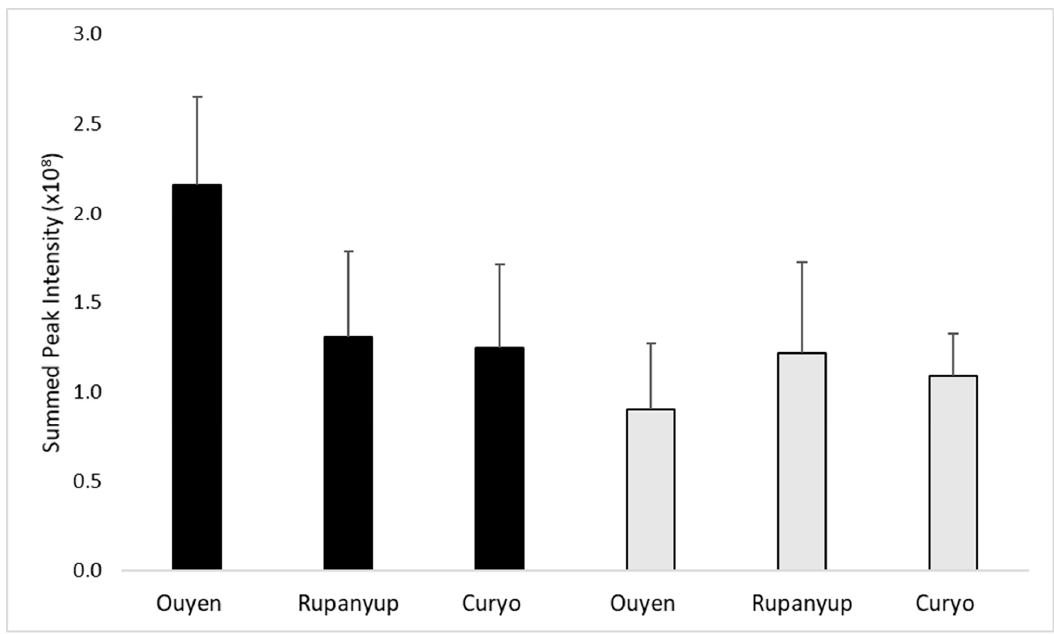
Figure 4. Relative content and standard deviation of carbohydrates in lentil cotyledons across replicates and sites of carbohydrates in the lentil cotyledons for PBA Jumbo2 (black bars) and CIPAL1602 (grey bars). (O = Ouyen, R = Rupanyup, C = Curyo). The PBA Jumbo2 samples from Ouyen have